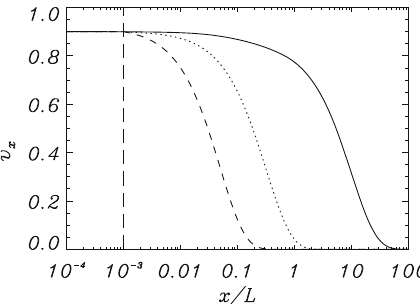
Fig. 52 Normal velocity component (in arbitrary units) of the kink mode in the direction across the thread axis. The ratio of the thread “diameter” to the length of magnetic field lines is 0.001, while the ratio of the thread length to the field lines length is 0.1. The solid, dotted and dashed lines correspond to k y L = 0 (curve of Fig. 51b), k y L = 3 and k y L = 20. All other parameter values are those of Fig. 51. The thread boundary is marked by a vertical dashed line. Image reproduced with permission from Díaz et al. (2003), copyright by